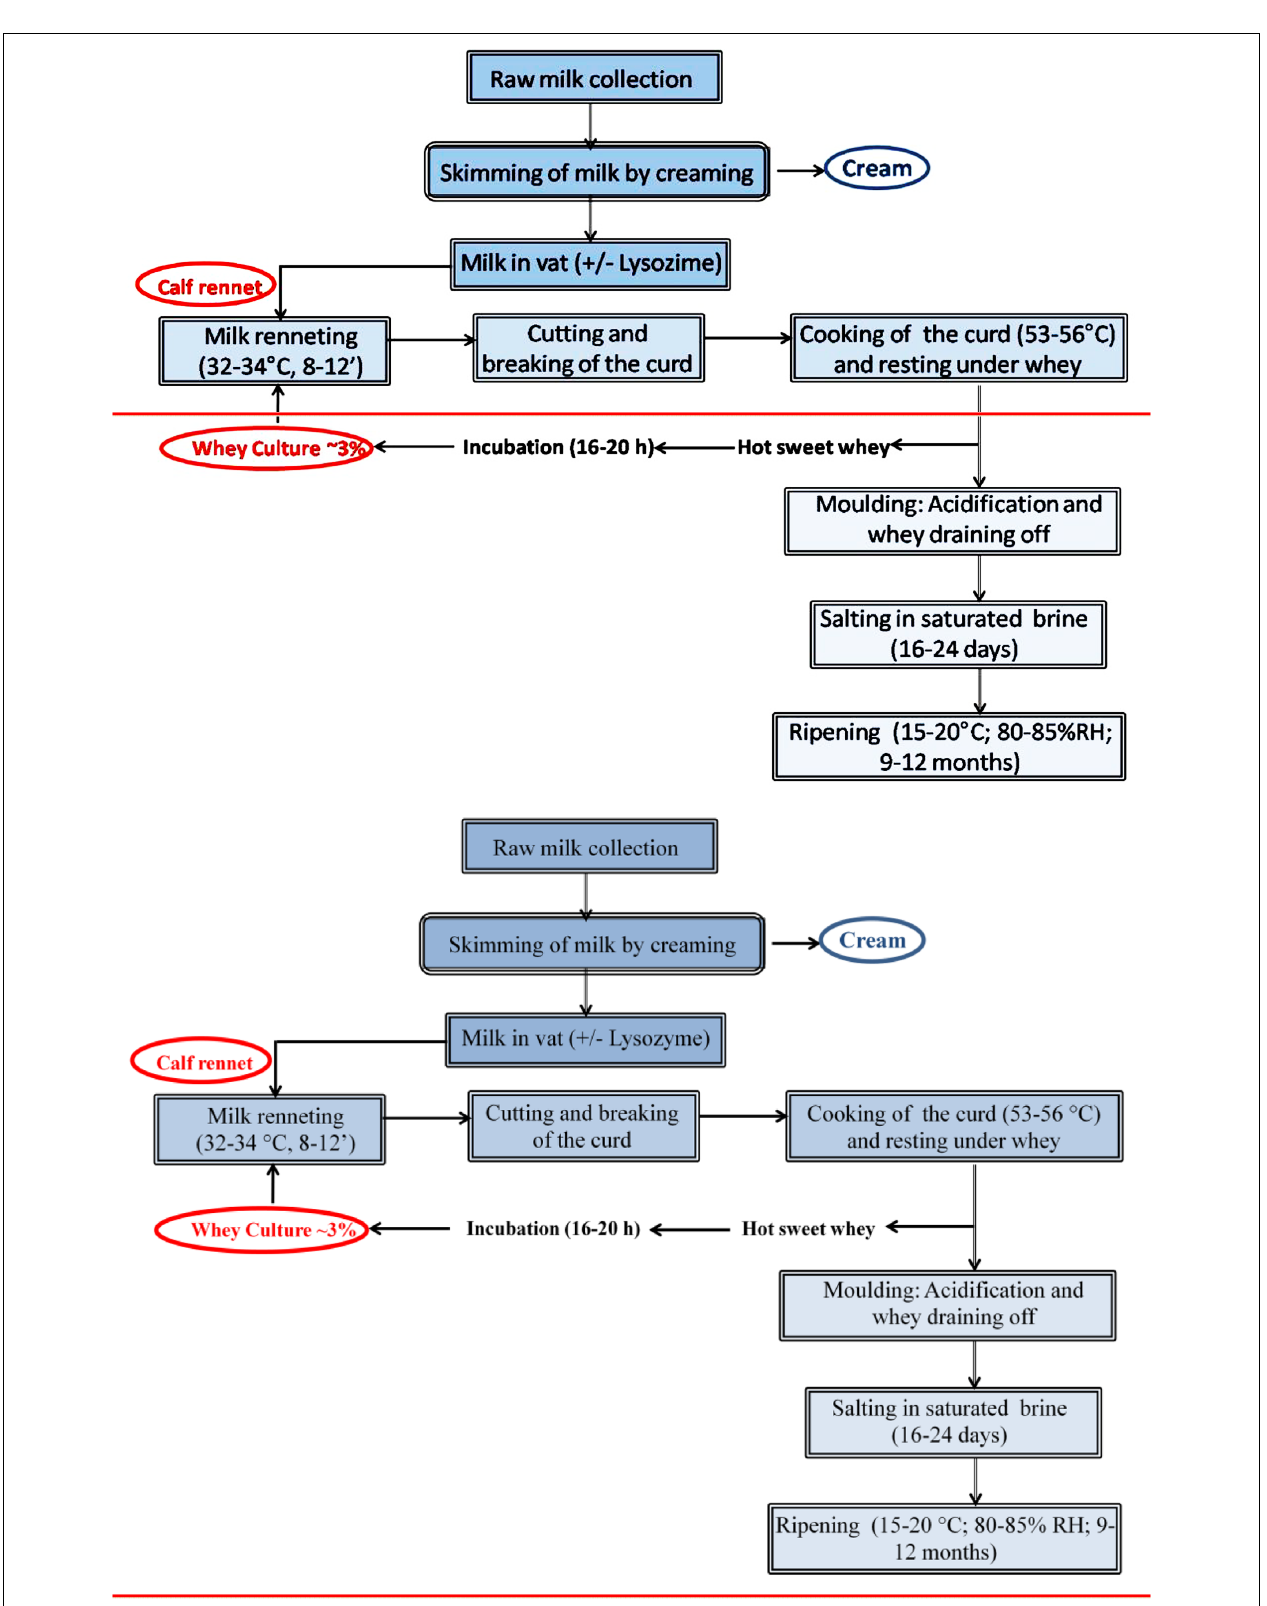
FIGURE 1 | Grana Padano (GP) and Parmigiano Reggiano (PR) cheese-making